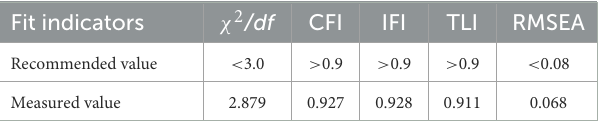
TABLE 4 Goodness-of-fit